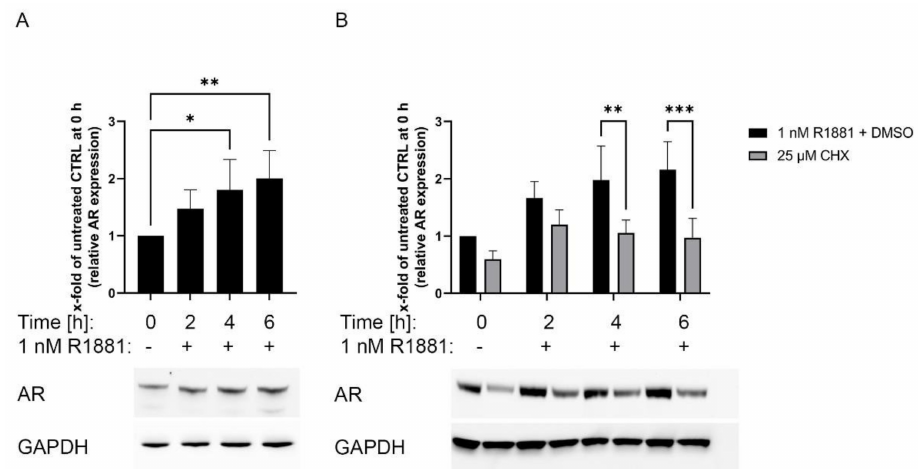
Figure 5. Cycloheximide inhibits R1881 induced AR protein increase: ( A ) Relative change and representative Western blot of 1 nM R1881 treated LNCaP cells after 2,4, and 6 h. ( B ) Relative change and representative Western blot of 1 nM R1881 treated LNCaP cells combined with DMSO (vehicle control) or 25 µ M Cycloheximide (CHX) in LNCaP cells after 2,4, and 6 h. Values are expressed as x-fold of untreated cells and are displayed as mean ± s.d. ( n = 3). All differences highlighted by asterisks were statistically significant (* p ≤ 0.05, ** p ≤ 0.01, *** p ≤ 0.001). Uncropped Western blots are displayed in Figure